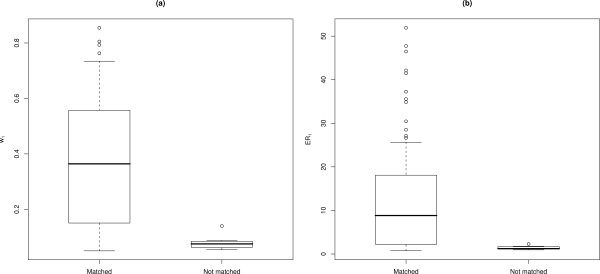
Matching validation results. Box-and-whisker plots of (a) IC weights (w1) for known matched pairs showing images matched and not matched with I3S; (b) evidence ratios (ER1) for known matched pairs showing images matched and not matched using I3S. Central tendency (black horizontal line) indicates the median, and whiskers extend to 0.5 of the inter-quartile range.